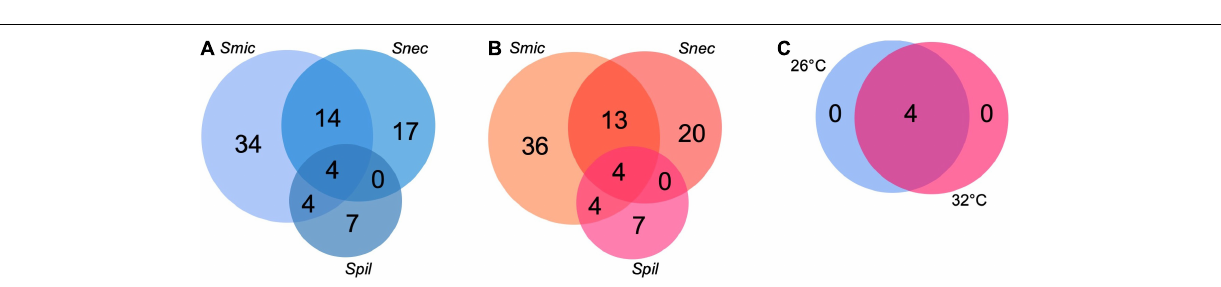
FIGURE 4 | Shared number of genera present in each core microbiome for two temperatures, independent of Symbiodinium species (A,B) . Combined core microbiome identified at 26 ◦ C and 32 ◦ C, across the three species of Symbiodinium (C) . To be considered part of the core microbiome at each temperature, the OTU must be present in all replicates ( n = 18). See Supplementary Figures 2, 3 for